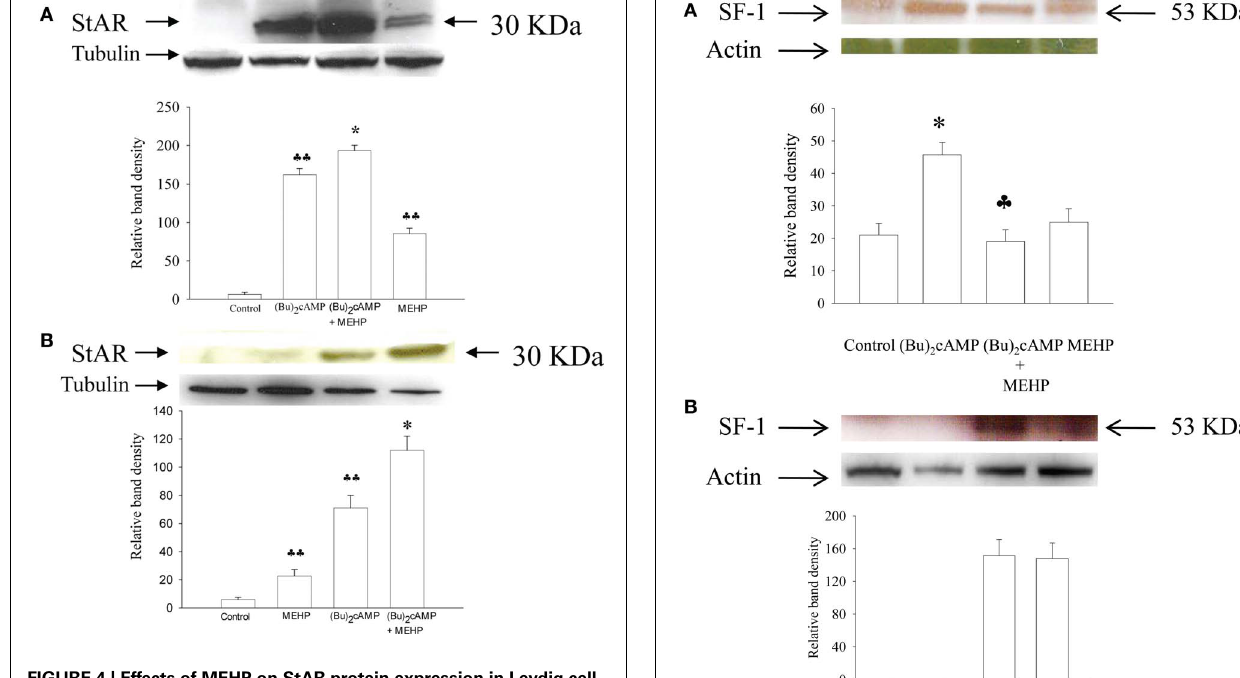
FIGURE 4 | Effects of MEHP on StAR protein expression in Leydig cell progenitors (A) and immature granulosa cells (B) stimulated with (Bu) 2 cAMP. The cells were pretreated with MEHP (250 μ M) or culture medium alone for 24h and thereafter incubated with (Bu) 2 cAMP (1mM) in the presence or absence of this same concentration of MEHP for an additional 24h.The cells were lysed and whole cell lysates (50 μ g protein) employed to analyze the levels of StAR protein by western blotting as described in Section “Materials and Methods.” Each StAR-specific band was quantified using NIH Image software and normalized to the optical density of tubulin.The mean values ± SEM for three independent steroidogenic cell preparations are presented. ♣♣ p < 0.01 compared to untreated control; * p < 0.05 compared to treatment with (Bu) 2 cAMP.